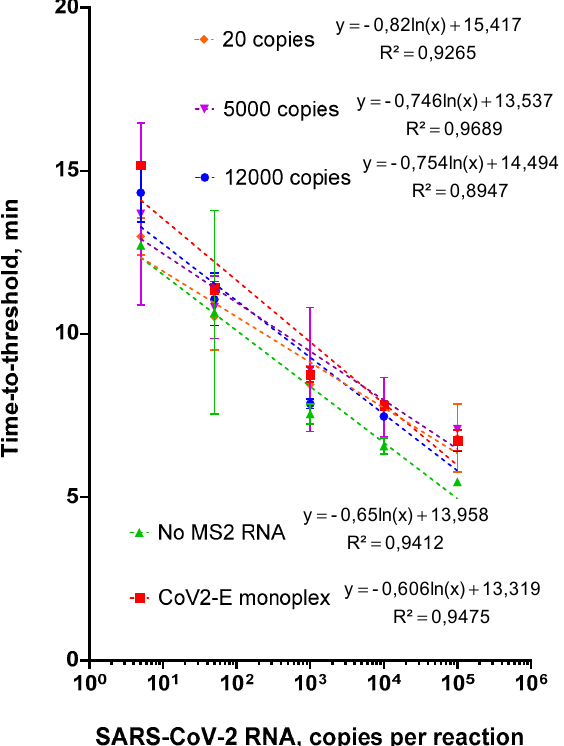
Figure 4. LAMP with CoV-2-E monoplex, duplex and various MS2 RNA concentrations. Each MS2 RNA concentration is marked by the color specified in the legend. Tt values are presented on the X-axis, and the amount of MS2 RNA per reaction on the Y-axis. Each run was triplicated; error bars represent one SD.